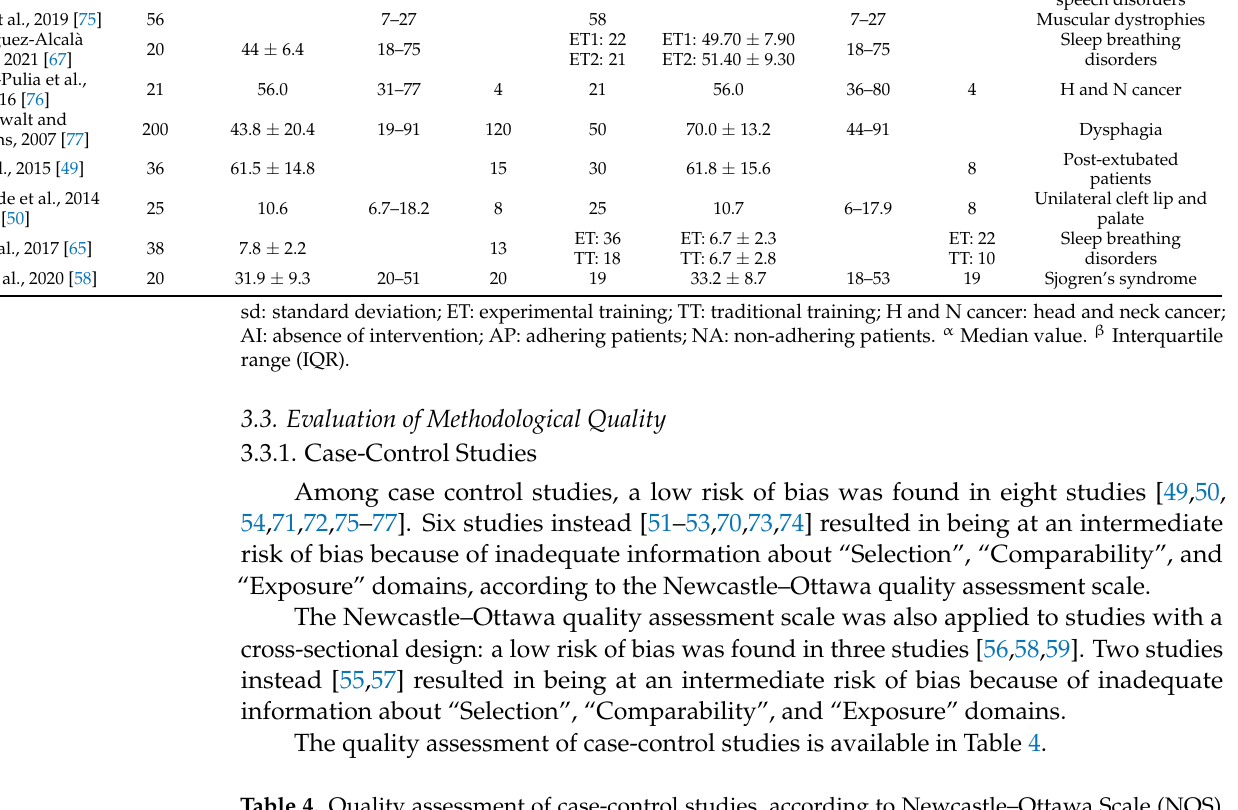
Table 4. Quality assessment of case-control studies, according to Newcastle–Ottawa Scale